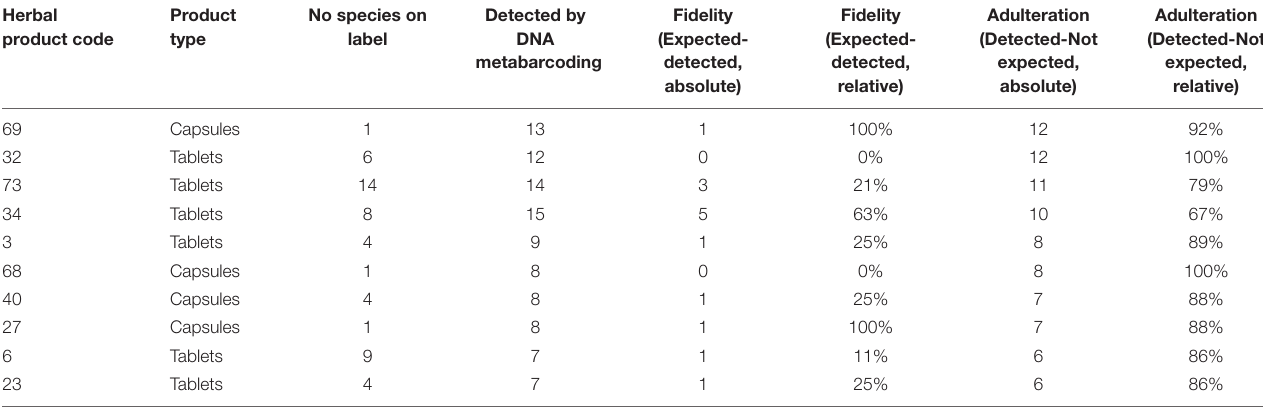
TABLE 3 | Top ten products with the highest adulteration and their fidelity. Herbal product